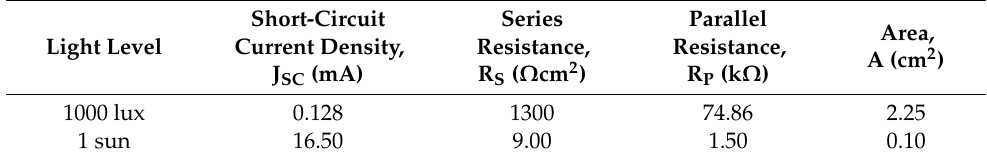
Table 2. PV data used in the